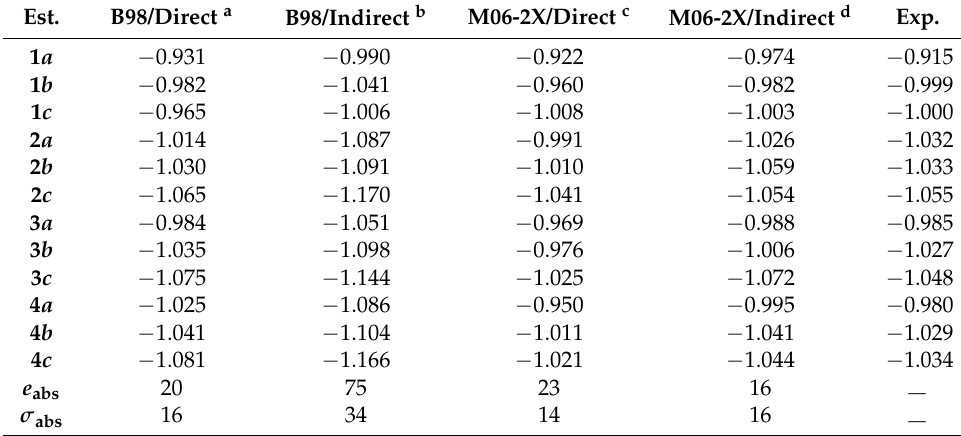
Table 5. Theoretical reduction potentials calculated at DFT level with C-PCM continuum solvation model of 12 investigated nitroaromatic MBHA. Reduction potentials values are in volts, mean absolute errors ( e abs ) and standard deviation of absolute errors ( σ abs ) are in millivolts. Est. B98/Direct a B98/Indirect b M06-2X/Direct